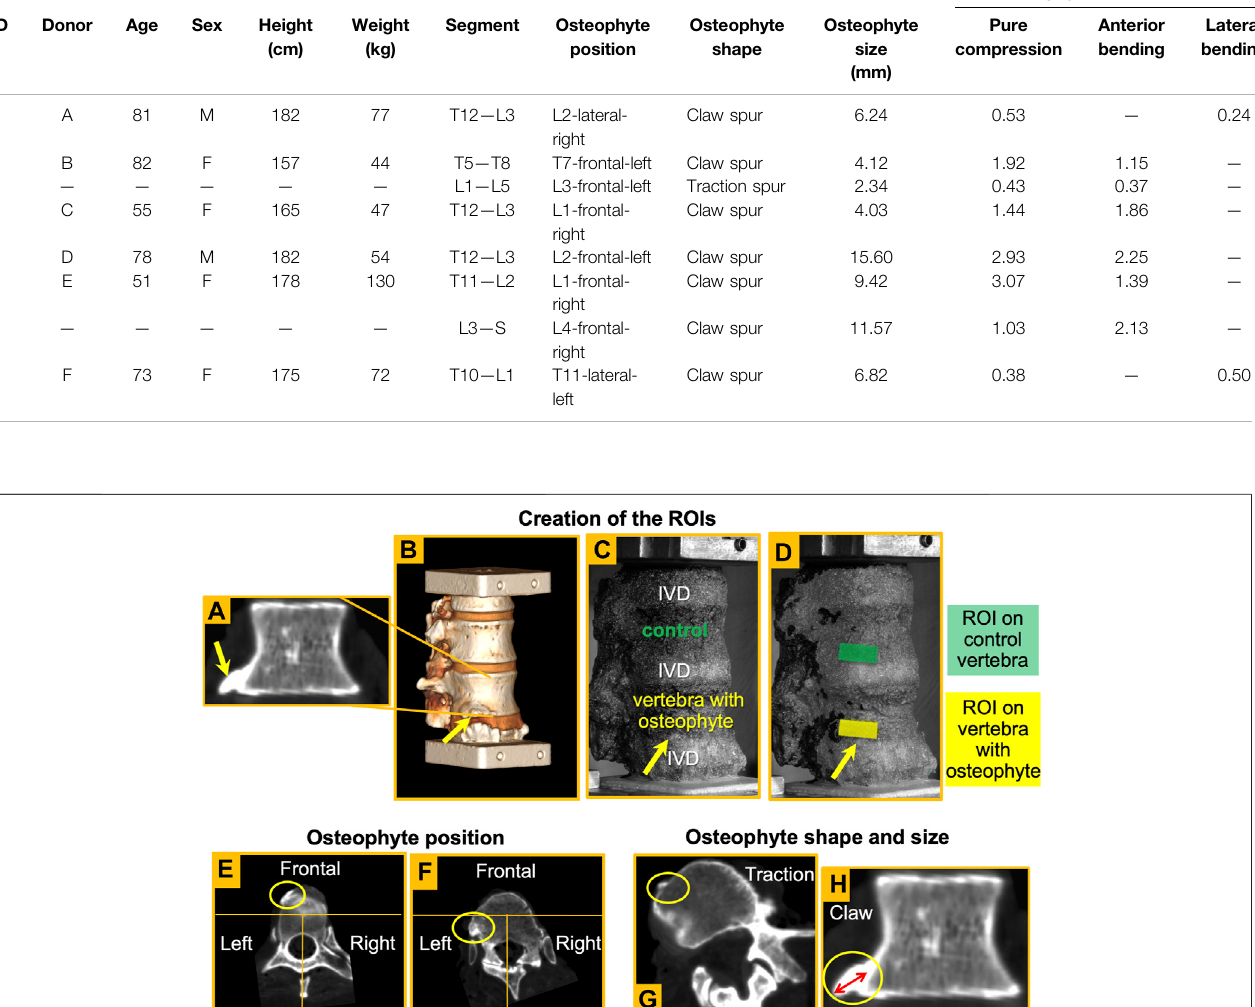
Osteophyte-to-control ratio